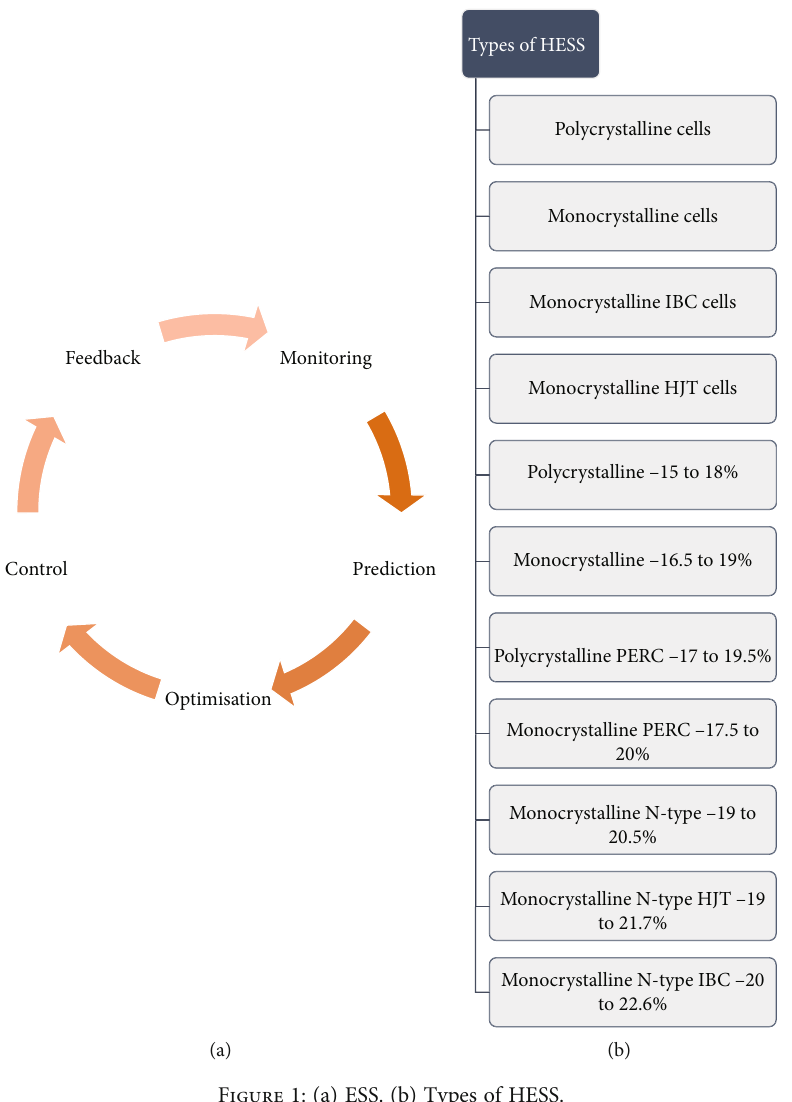
Figure 1: (a) ESS. (b) Types of